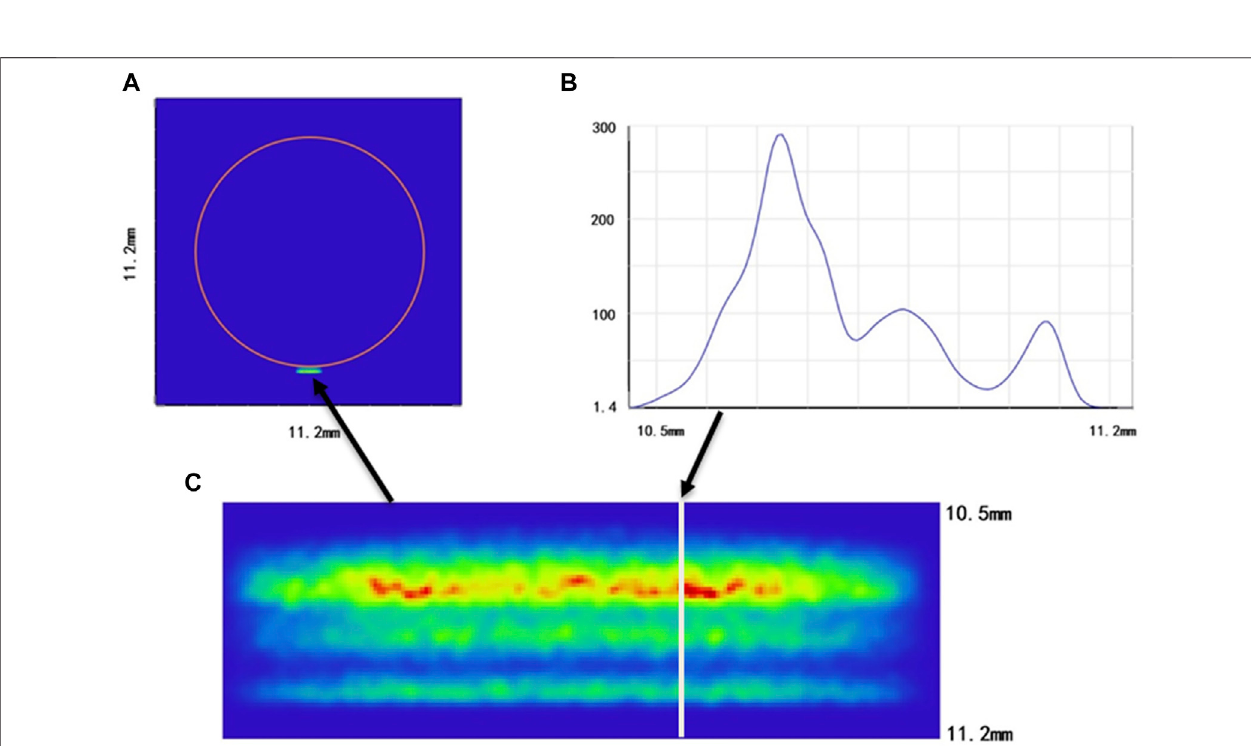
FIGURE 4 | Simulation results of diffracted stray-light at 700.0 nm. (A) Diffracted stray-light image at the Lyot stop A2 position. (B) Relative intensity distribution curve of diffracted stray-light from a radius of 10.5 – 11.2 mm. (C) Partial enlarged view of a diffracted stray-light image.